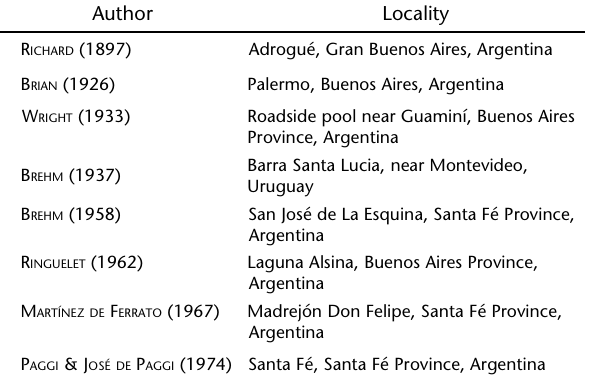
Table I. Previous records of Argyrodiaptomus bergi